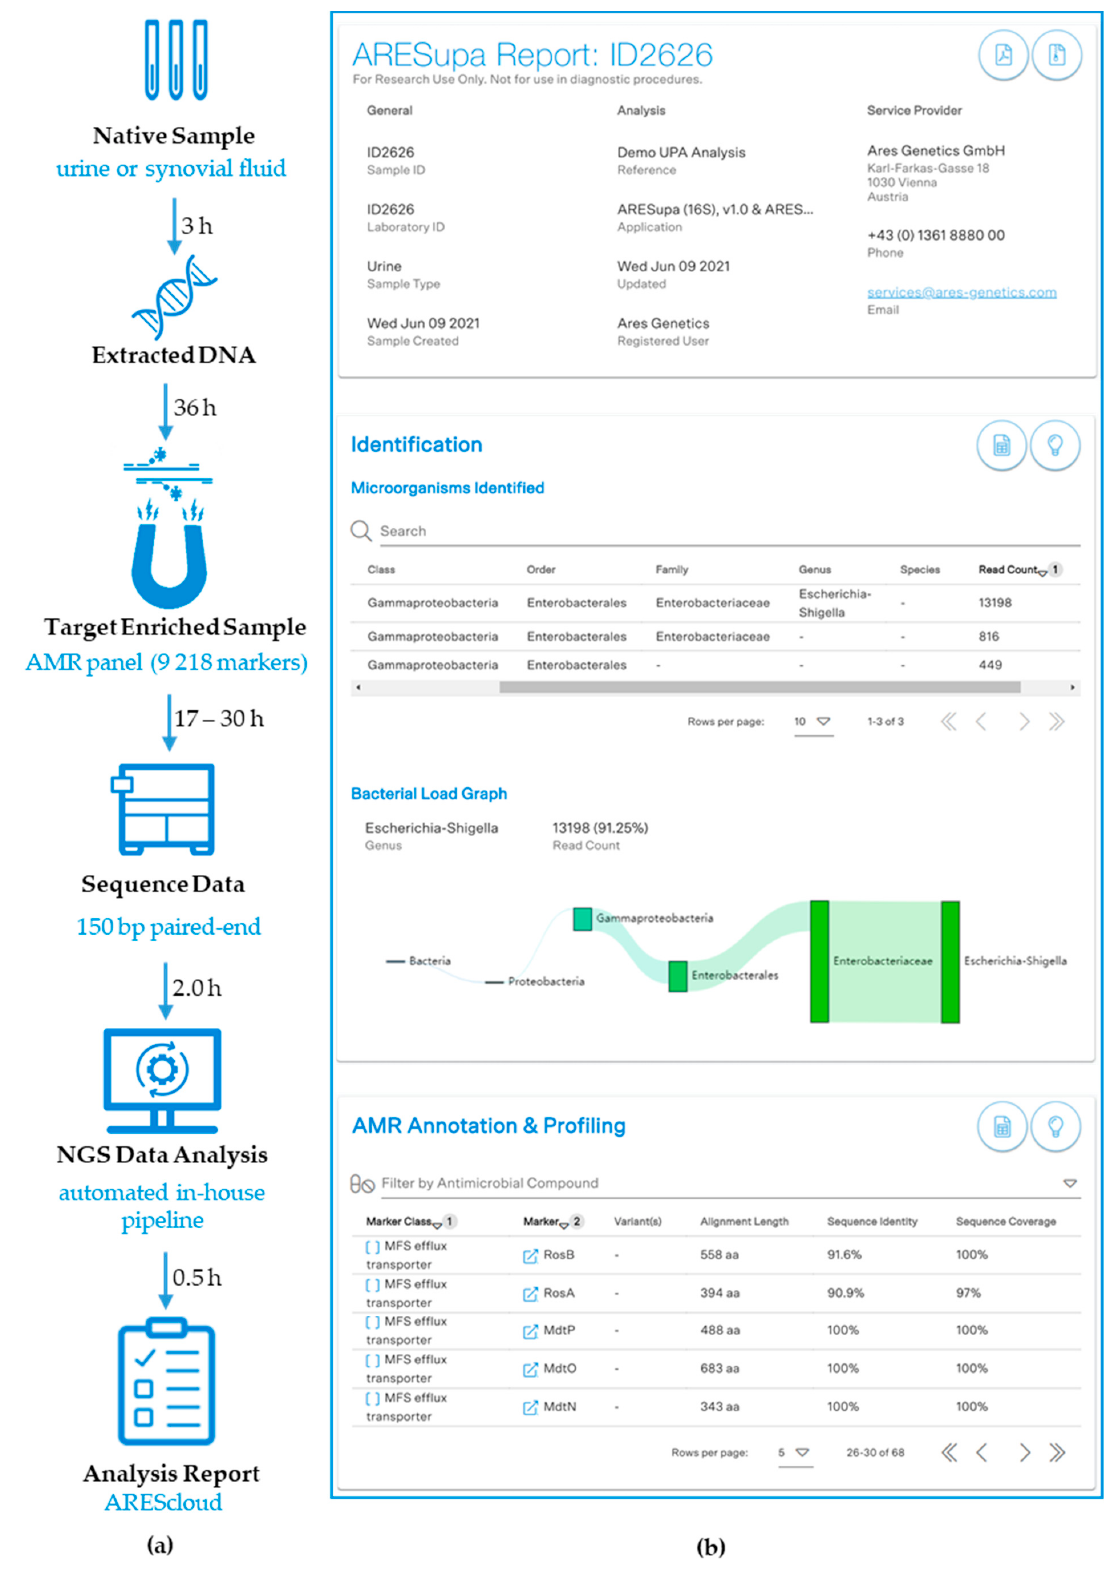
Figure 1. Workflow from sample to result. ( a ) Flow chart of the target enrichment workflow established and tested for synovial fluid and urine samples. ( b ) Example of the standardized sample report implemented on AREScloud to summarize AMR marker profiling results and taxonomic identification via 16S rRNA